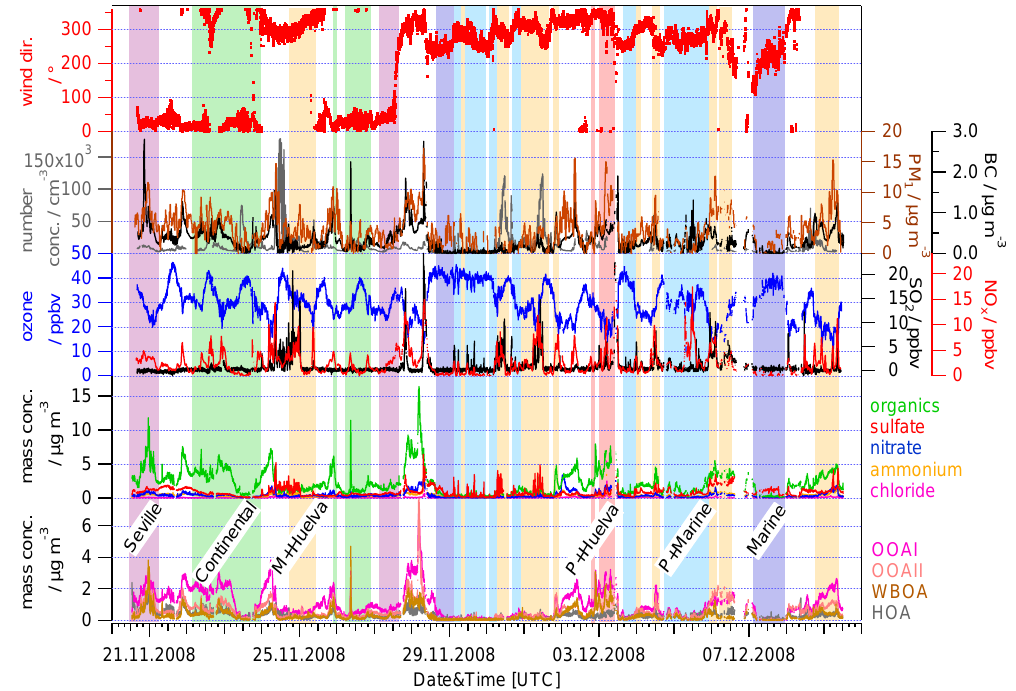
Fig. 4 Fig. 4. Time series of several parameters (wind direction (red), number (grey) and PM 1 mass (brown) concentrations, black carbon (black), ozone (blue), sulfur dioxide (SO 2 , black), nitrogen oxide (NO x , red), AMS species (organics (green), sulfate (red), nitrate (blue), ammonium (orange), chloride (purple), OOAI (purple), OOAII (salmon), WBOA (brown), HOA (grey)) measured during the DOMINO campaign and discussed in the paper. The classified air mass categories are indicated as shaded areas behind the traces (“Seville” (purple), “Continental” (green), “Portugal+Huelva” (red), “Marine+Huelva” (orange), “Portugal+Marine” (light blue), “Marine”